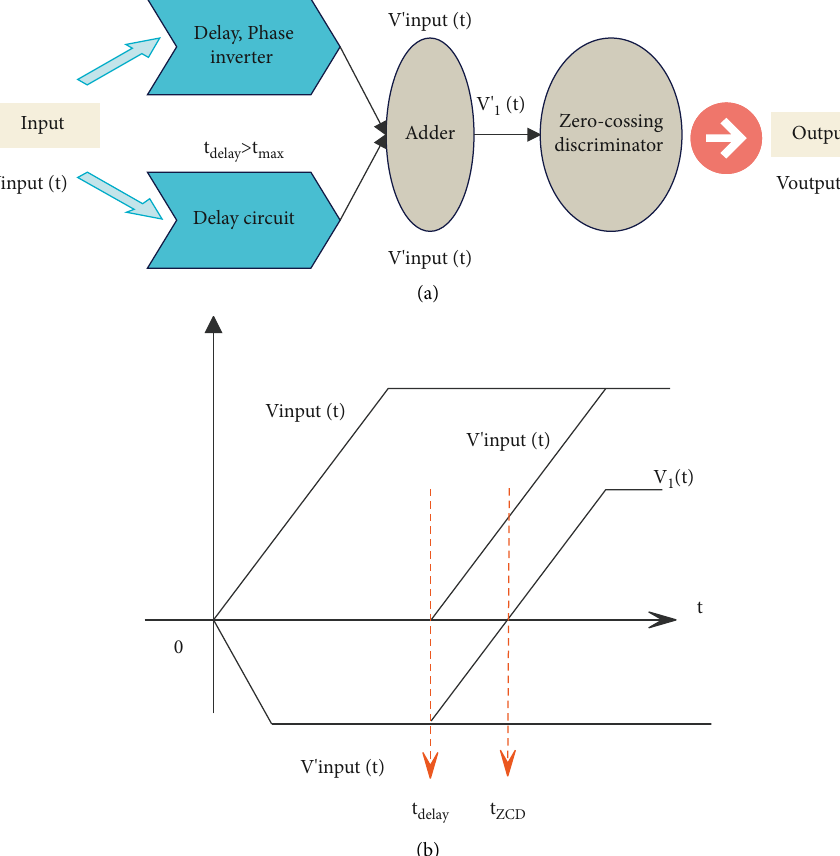
Figure 5: Schematic diagram of constant ratio